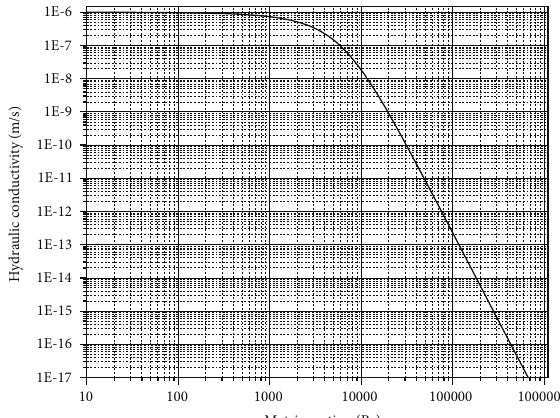
Figure 3: Curve of hydraulic conduction function.